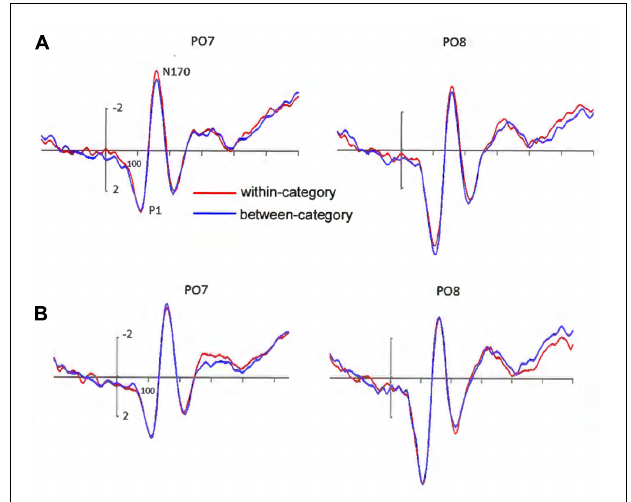
FIGURE 3 | (A) Grand-averaged ERPs elicited by within-category and between-category stimuli. The amplitude of the N170 was larger under the within-category condition. (B) Grand-averaged ERPs elicited by the same pairs, they were separated according to in which condition these stimuli were used. The amplitude of the N170 elicited by the same pairs did not show valence category effect.